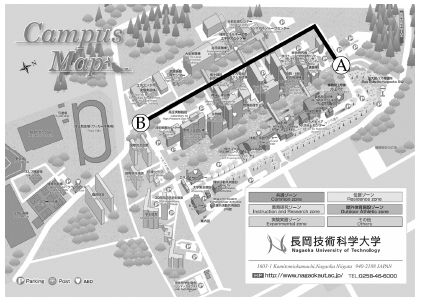
Figure 1. Experimental route (in Nagaoka University of Technology)